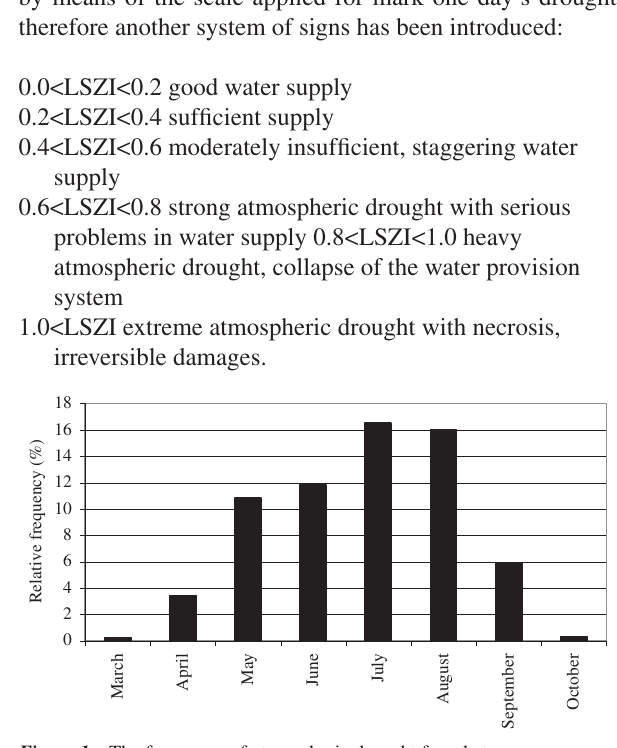
Figure 1 – The frequency of atmospheric drought found at